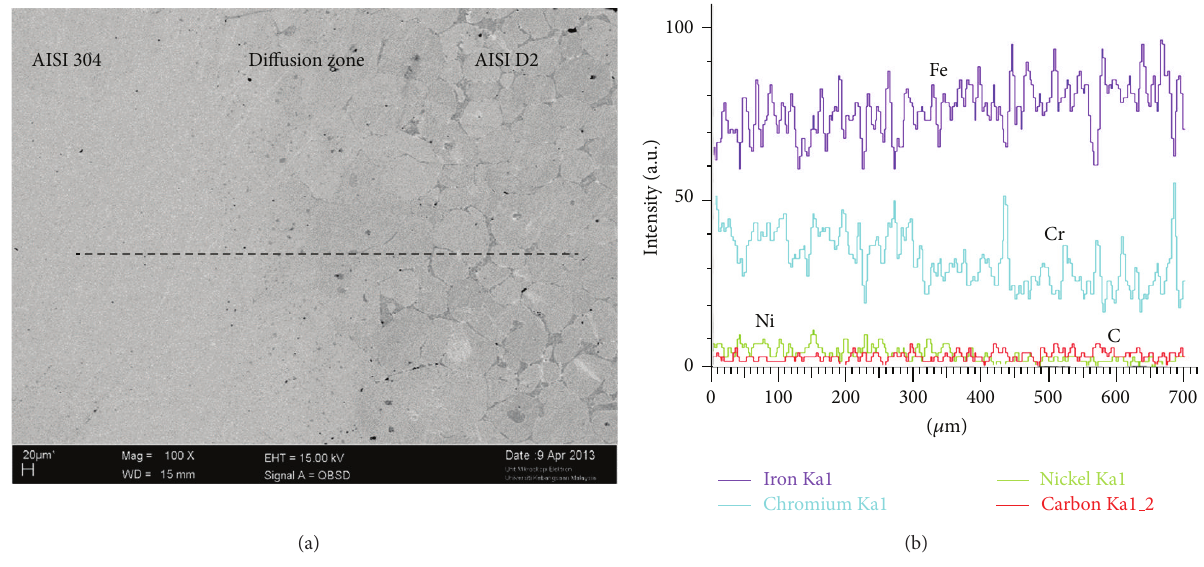
Figure 9: Elemental distribution across the joint centre in AISI D2-AISI